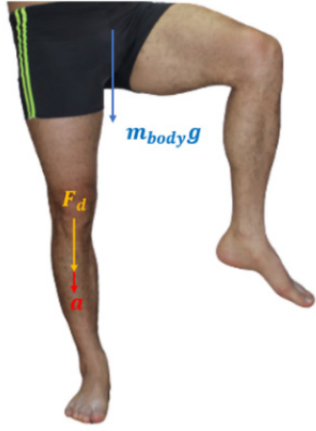
Figure 1. Free body diagram in the rolling phase.